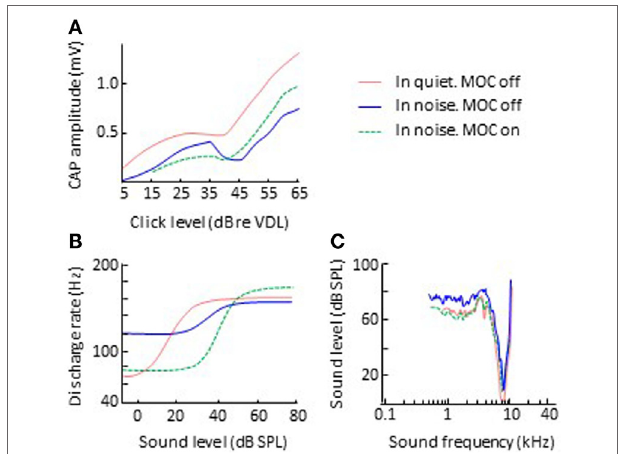
FiGURe 3 | Effects of olivocochlear efferent activation on physiological responses to sound in noise. The left and right panels illustrate corresponding input/output and threshold tuning curves, respectively. (B,C) Single auditory nerve fiber responses. Data in panels (B,C) are re-plotted, in modified form, from Winslow and Sachs (54) and Kawase et al. (55), respectively. (A) CAP. Data in panel A re-plotted, in modified form, from Nieder and Nieder (52). Abbreviations: CAP, compound action potential; VDL, visual detection